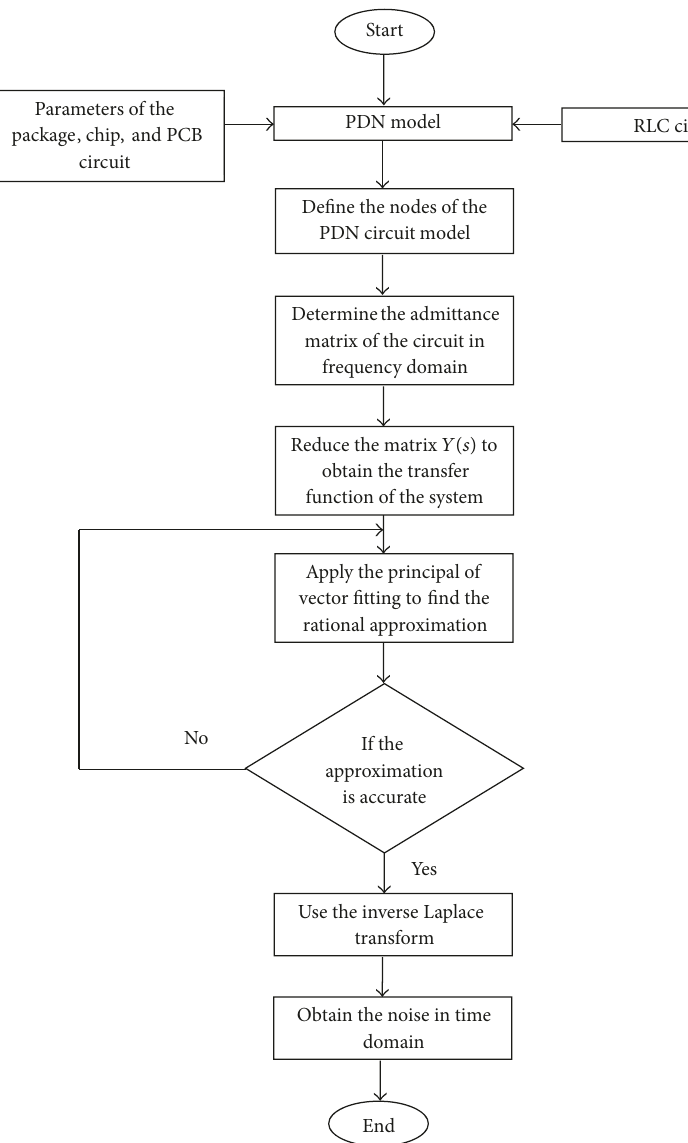
Figure 6: SSN analysis